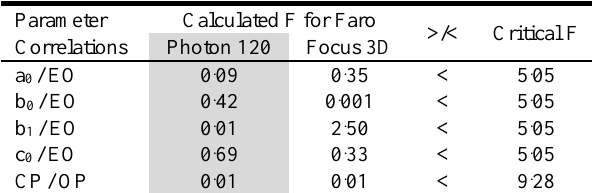
Table 1. F-variance ratio test for full network configuration.